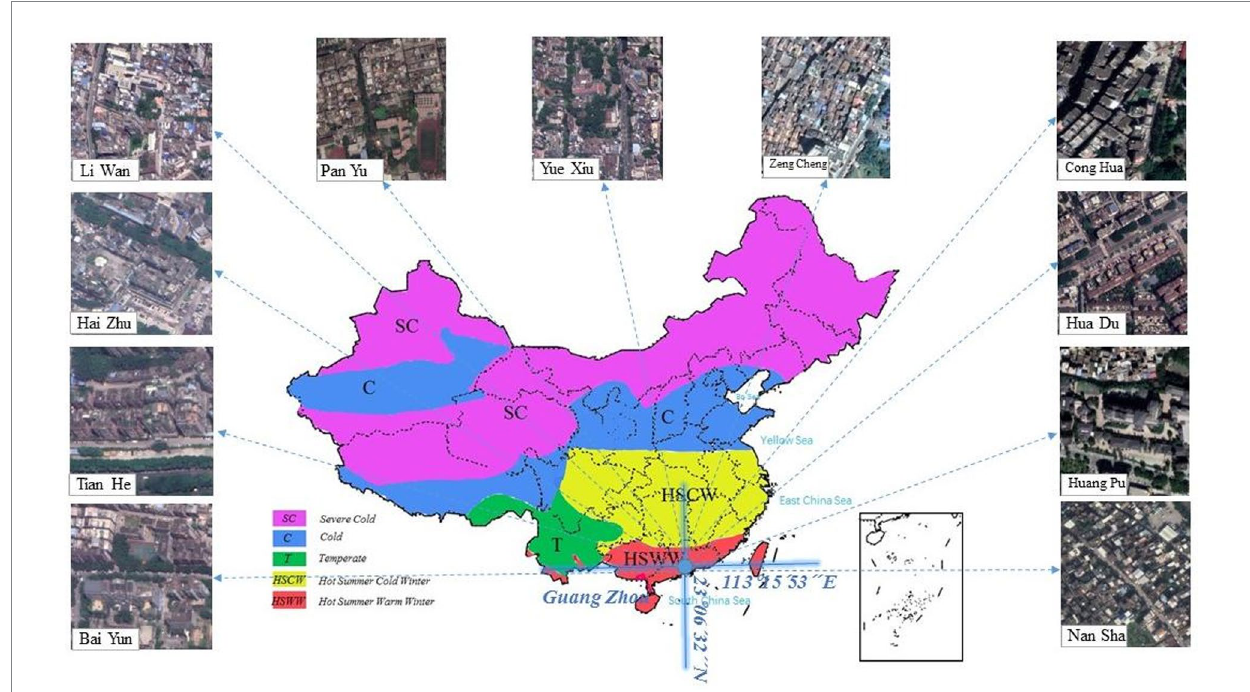
FIGURE 1 The location of Guangzhou and its